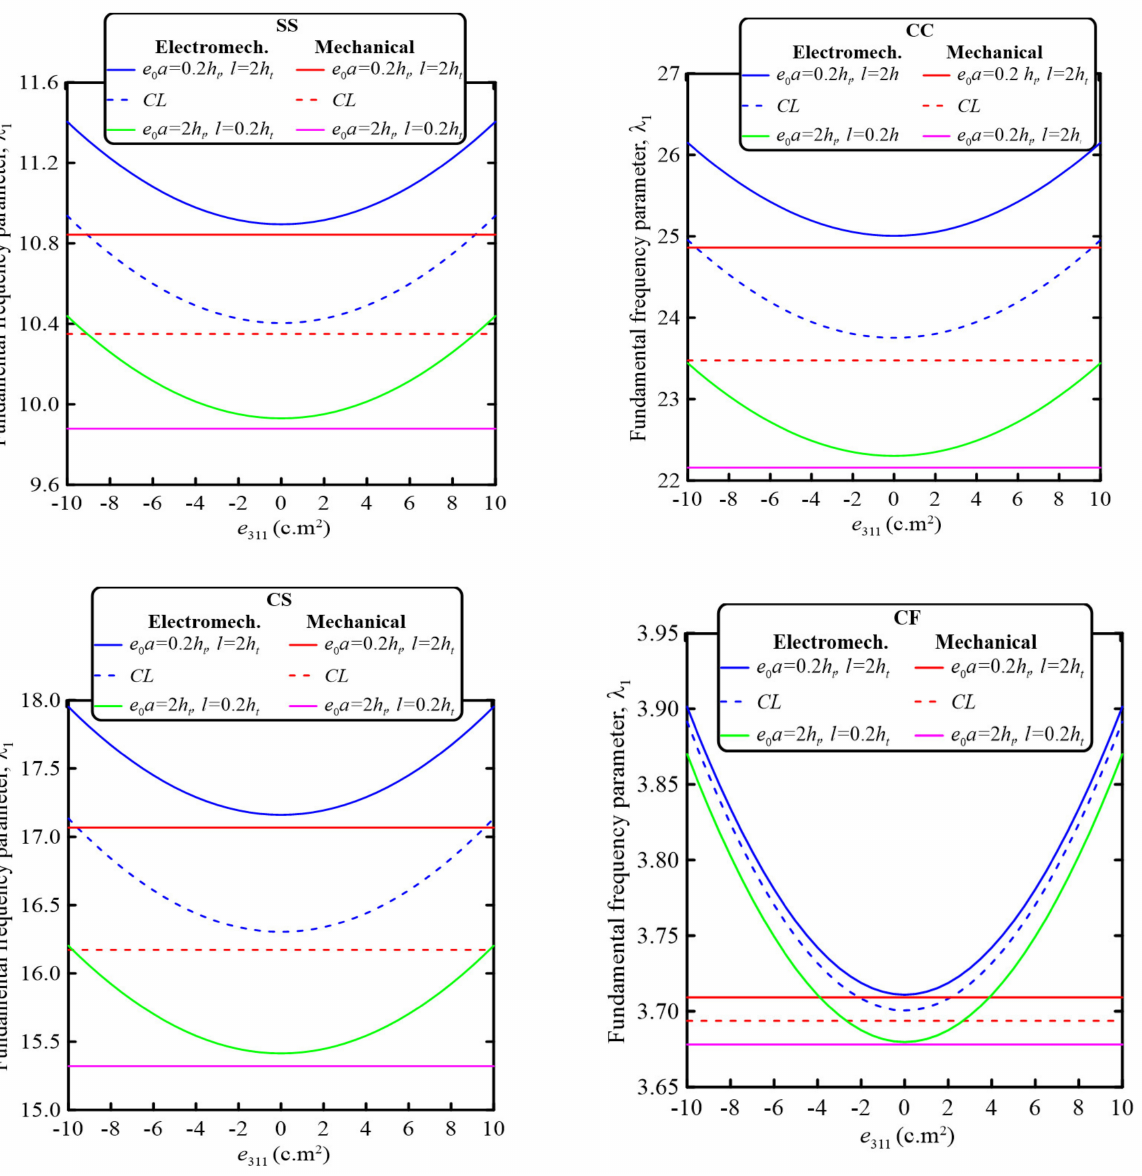
Figure 6. Variation of the fundamental frequency parameter λ 1 with the piezoelectric coefficient e 311 for nonclassical and classical electromechanical and mechanical analyses of piezoelectric sandwich nanobeams at different values of strain gradient and nonlocal parameters for different beam boundary conditions at × 10 − 8 C/m, and a × 10 − 9 C/m 2 α = 0.5 and beam aspect ratio L / h t = 20 (N = 4, µ 3111 = 5 33 = 7.124